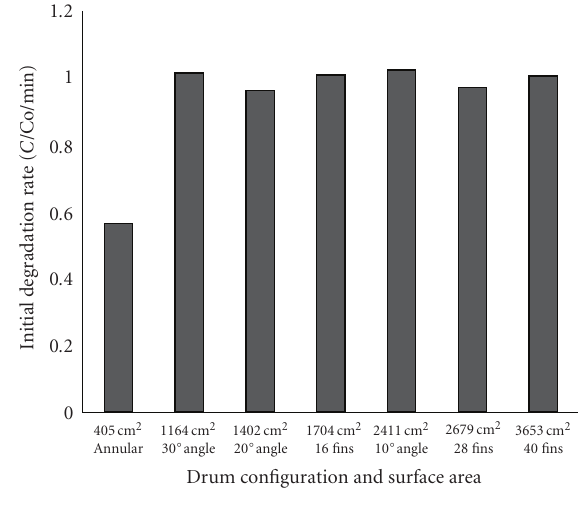
Figure 5: Comparison of percent degradation for all drums at trial with Co = 15 ppm,